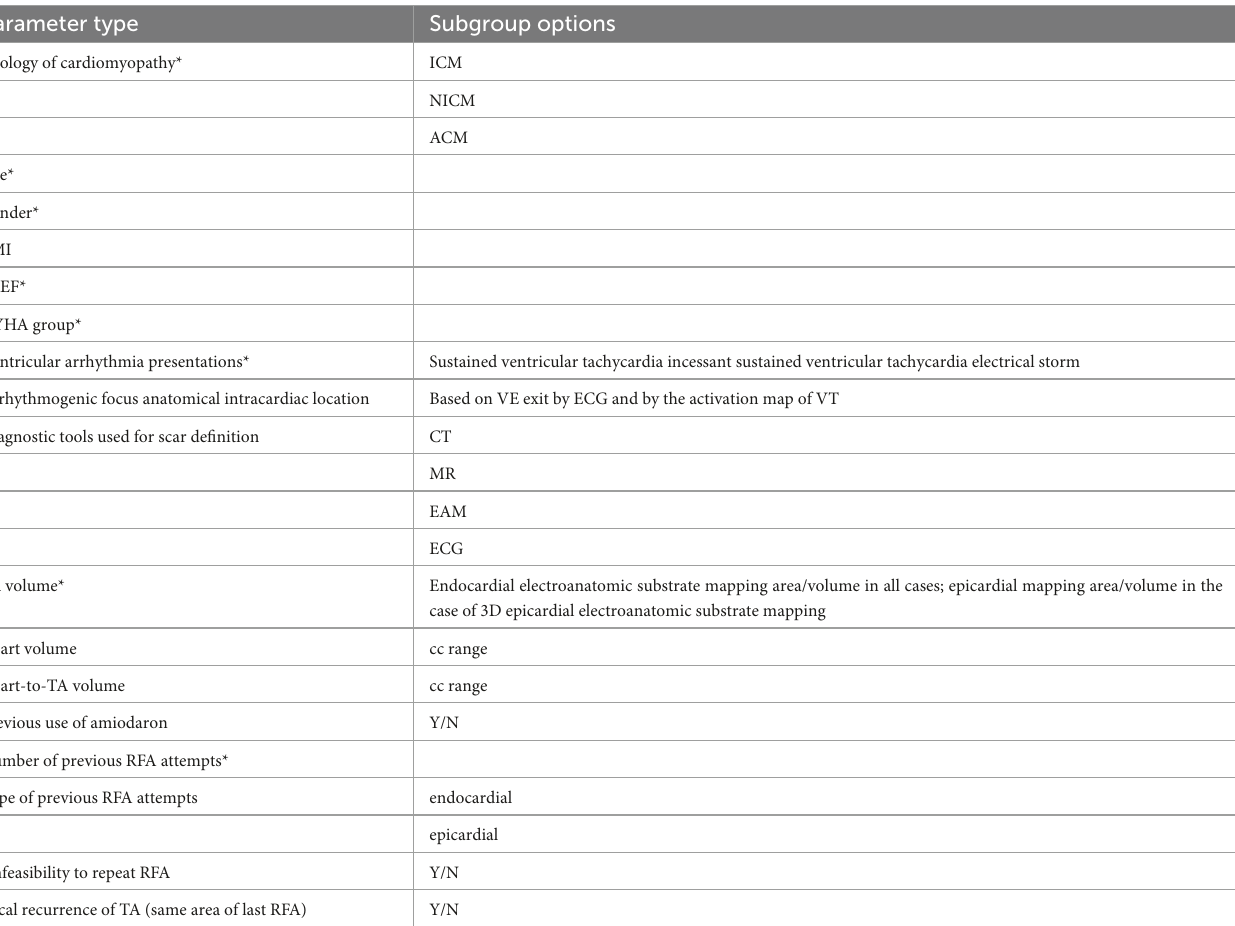
TABLE 2 Applied matching factors.